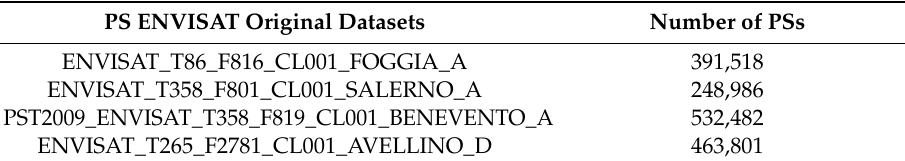
Table 2. ENVISAT Permanent Scatterers datasets used in this study. PS ENVISAT Original